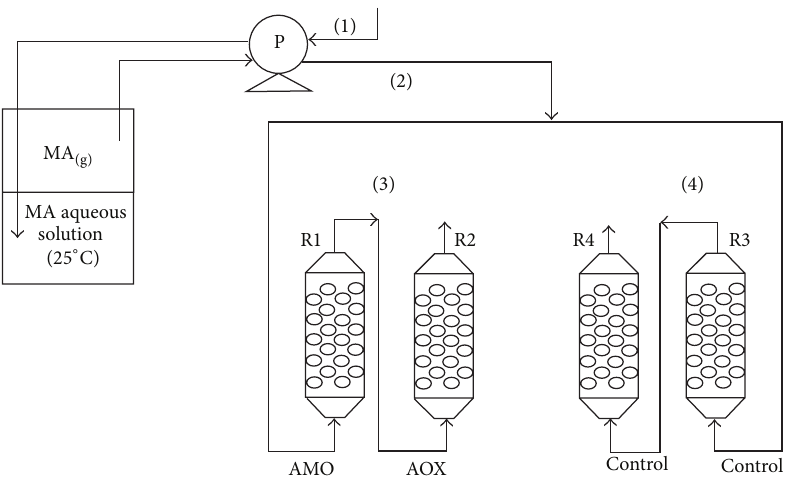
Figure 2: Scheme of a two-step CFBR system for bioconversion of airborne MA by AMO immobilized in CA (R1) and for oxidation of the produced FA by immobilized AOX (R2). The control columns (R3 and R4) contained blank CA-gel beads. (1) an airflow bubbled through aqueous MA solution; (2) a flow of airborne MA; (3) a system of two CFBR in series; (4) a control system and P-a peristaltic pump.